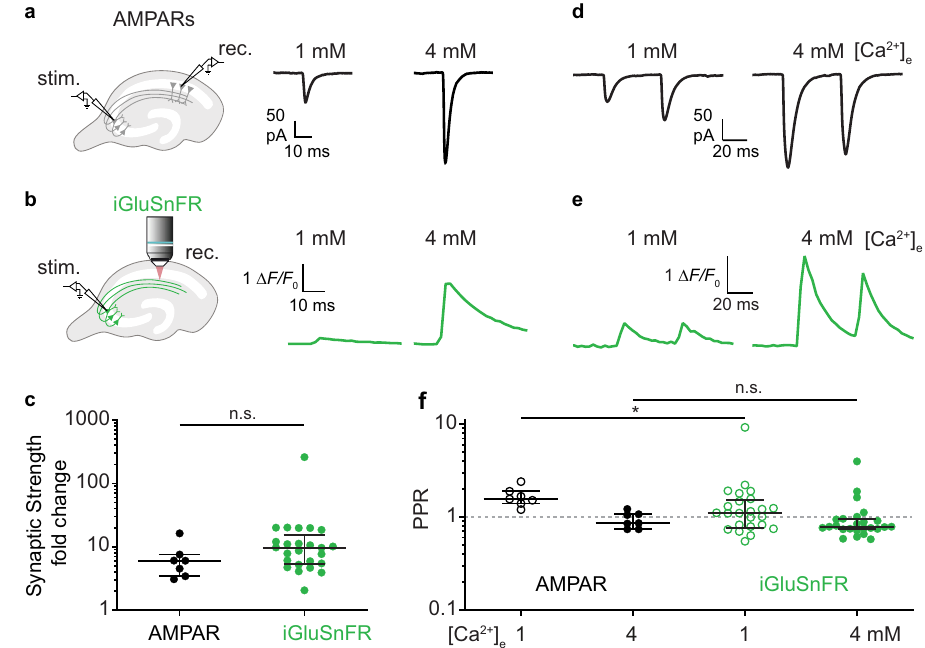
Fig.4|Multivesicularreleaseincreasesthegainandthesignaltonoiseratioof synapses.a EPSCsweremeasuredbydualpatch-clamprecordingsfromconnected CA3-CA1 pyramidal cell pairs. Perfusion was switched from 1mM to 4mM [Ca 2+ ] e , leading to increased EPSC amplitudes. Traces show EPSCs (average of ~40 trials) from the CA1 pyramidal cell. b Traces show the evoked change in fl uorescence (averageof~60trials)fromasingleboutoninCA1stratumradiatum.Theswitching sequence(low-high[Ca 2+ ] e /high-low[Ca 2+ ] e )wasreversedbetweenexperiments. c Increasing [Ca 2+ ] e from 1 to 4mM increased the median amplitude of AMPAR- mediated EPSCs by a factor of 6.02, interquartile range (IQR): 3.4 – 7.5-fold, n =7 pairs, the median iGluSnFR response by 9.63-fold, IQR: 5.3 – 15.2-fold, n =25 bou- tons. There is no signi fi cant difference between the fold change in AMPARs and iGluSnFR responses (two-sided Mann – Whitney, p =0.08). d Representative EPSCs (average of ~40 trials) in response to the presynaptic paired-pulse stimulation